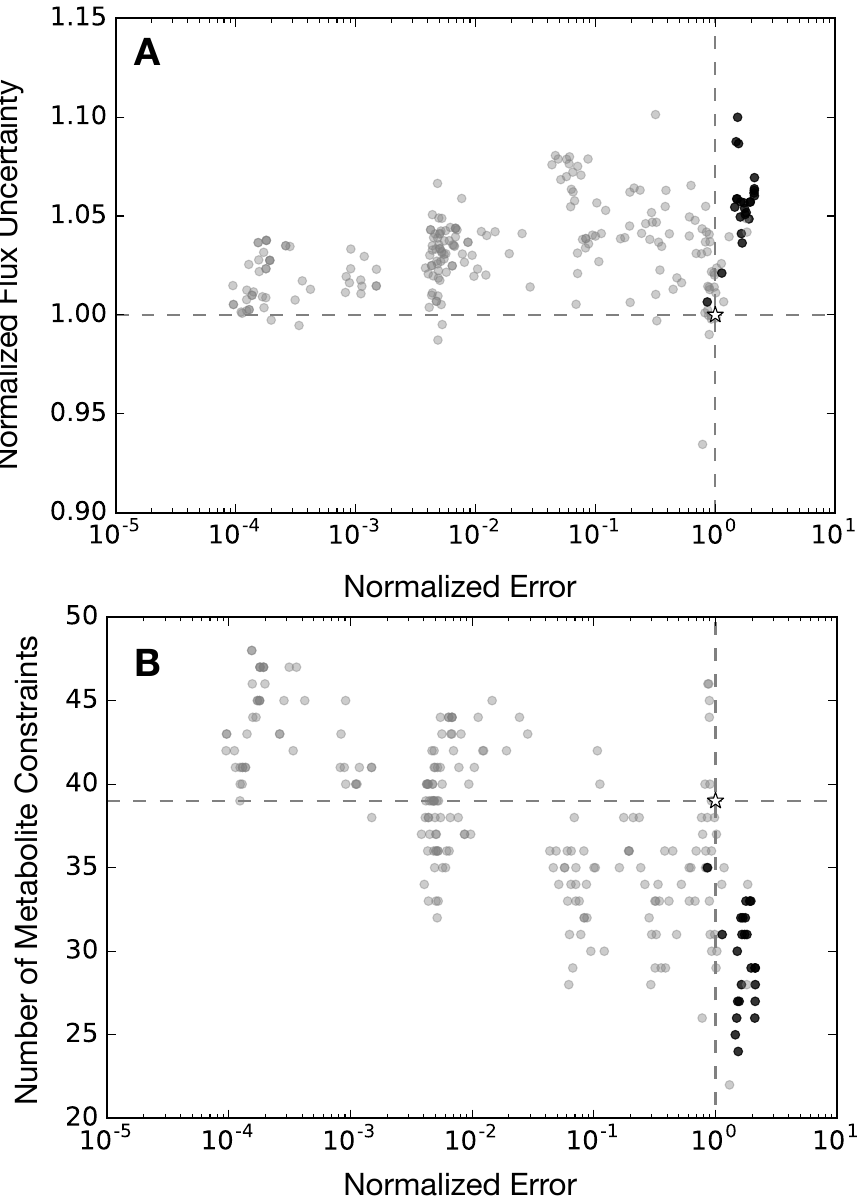
Figure 6. Flux uncertainty and metabolite prediction error for the simulated annealing experimental design approach. ( A ) normalized flux uncertainty versus normalized metabolite prediction error; ( B ) number of metabolite constraints versus normalized metabolite prediction error. Error was computed for the synthetic experimental designs normalized to the base synthetic dataset (white star). Sets that include glucose are show as gray circles, while those that do not are represented with black